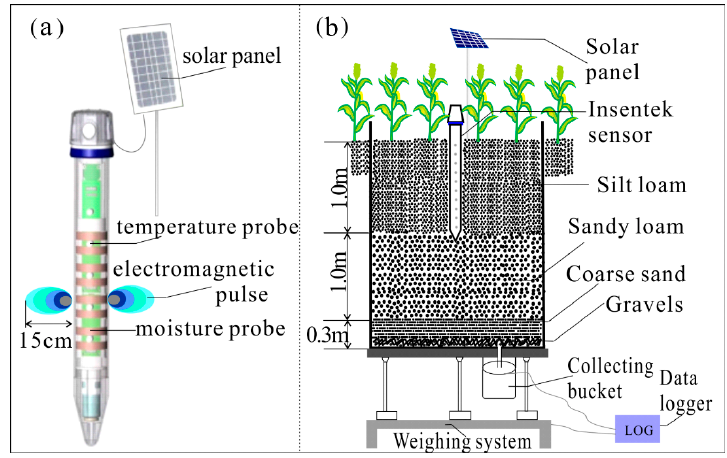
Figure 1. Insentek sensor and design of lysimeter experiment. ( a ) The structure and principle of an Insentek sensor; ( b ) lysimeter setup details and installation of an Insentek